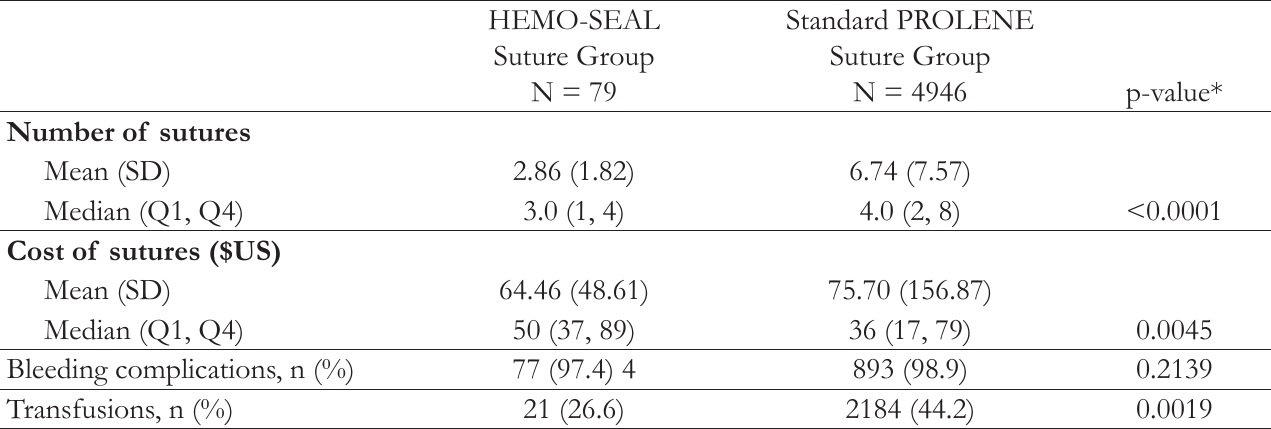
Table 3. Summary of the Results for the Secondary Outcomes